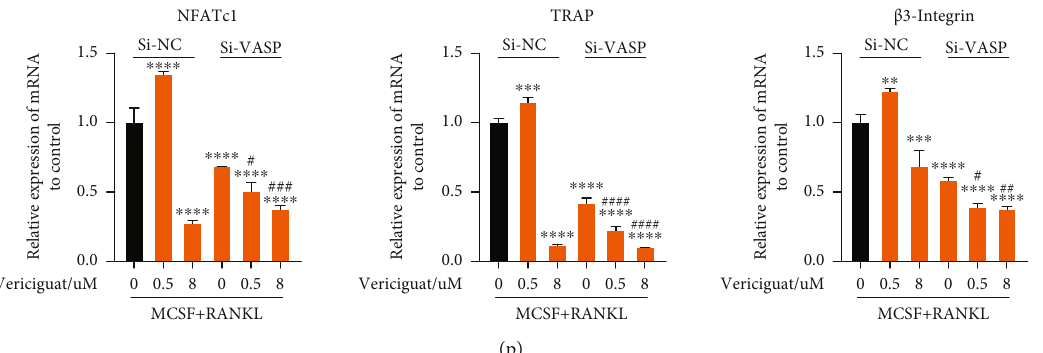
Figure 6: VASP was essential to osteoclast di ff erentiation, and the expression of VASP could be promoted by Vericiguat. (a) VEGT augmented the expression of VASP in a dosage-dependent manner ( n = 3 ). (b, c) RANKL enhanced the expression of VASP in a dosage- dependent manner and quantitative results ( n = 3 ). ∗ indicated a comparison with the control group without RANKL. (d) Immuno fl uorescence position of VASP in BMMs with or without RANKL. (e) The mRNA expression of VASP in BMMs after treatment with siRNA ( n = 3 ); ∗ indicated a comparison with the control group (si-NC). (f, g) The protein expression of VASP in BMMs after treatment with siRNA and quantitative results ( n = 3 ). ∗ indicated a comparison with the control group (si-NC). (h – l) The mRNA expression of OC-related genes in BMMs after treatment with siRNA ( n = 3 ). ∗ indicated a comparison with the control group: ∗ p < 0 : 05 , ∗∗ p < 0 : 01 , ∗∗∗ p < 0 : 001 , and ∗∗∗∗ p < 0 : 0001 . # indicated a comparison between the group with si-VASP and the group with si-NC: # p < 0 : 05 , ## p < 0 : 01 , ### p < 0 : 001 , and #### p < 0 : 0001 . (m) The protein expression of osteoclast-related genes in BMMs after treatment with siRNA and quantitative results ( n = 3 ). (n, o) The expression of NF- κ B protein in BMMs with or without siRNA-VASP treated with Vericiguat only ( n = 3 ). (p) The mRNA expression of osteoclast-related genes (NFATc1, TRAP, and β 3-Integrin) in siRNA-VASP- induced BMMs compared with siRNA-NC-induced BMMs ( n = 3 ); ∗ indicated a comparison with the control group (Vericiguat, 0nM) in the siRNA-NC group and si-VASP group, respectively: ∗ p < 0 : 05 , ∗∗ p < 0 : 01 , ∗∗∗ p < 0 : 001 , and ∗∗∗∗ p < 0 : 0001 . # indicated a comparison between the siNC-induced group and si-VASP-induced group at the same concentration of Vericiguat: # p < 0 : 05 , ## p < 0 : 01 , ### p < 0 : 001 , and #### p < 0 : 0001 . Scale bar = 100 μ m